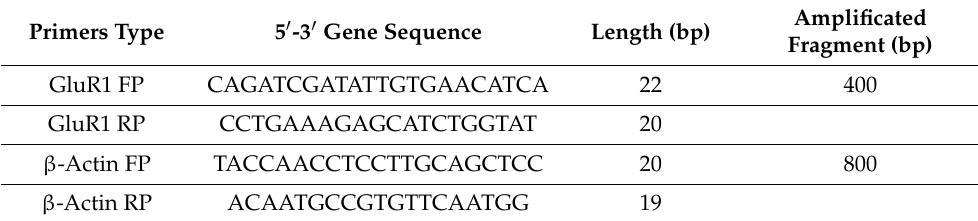
Table 3. Specific gene primers are utilized in the real-time